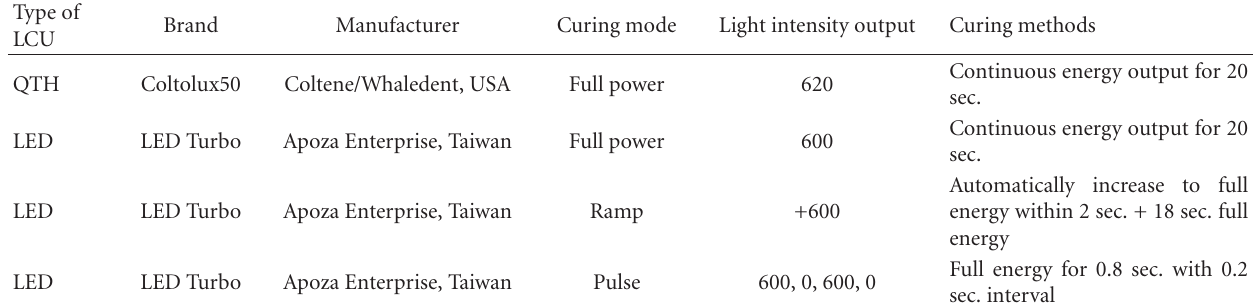
Table 2: Types of light curing units, their intensity and methods of